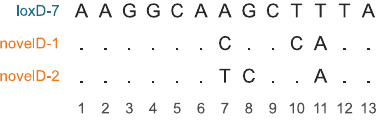
indicate that recombination could not be con fi rmed by sequencing. Dashes were placedwherenosequenceveri fi cationwasperformed.PRL:predictedrecombinase library, CRL closest recombinase library to novel target site in terms of target site similarity. Source data are provided as a Source Data fi